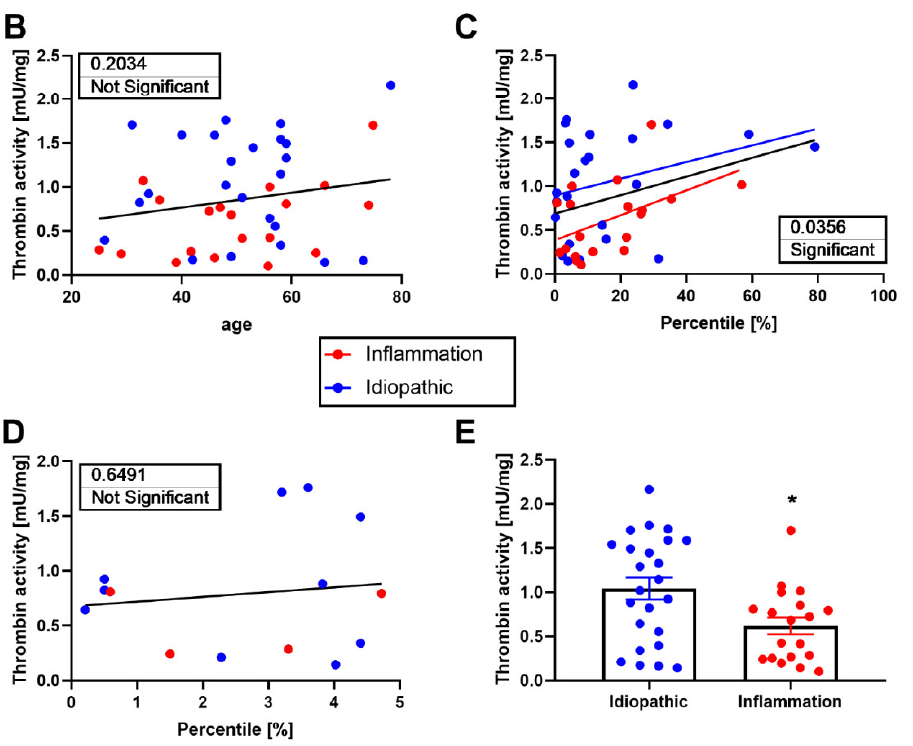
Figure 6. Thrombin activity in human skin: ( A ) Representative pictures of small-fiber staining of control (upper panel) and SFN (lower panel) patients. ( B ) No correlation was found between thrombin activity and age in all patients. p = 0.2, R 2 = 0.04, n = 43. ( C ) A significant correlation was found between thrombin activity and percentile in all patients. p = 0.035, R 2 = 0.1 for all patients; p = 0.032, R 2 = 0.24 for inflammation; and p = 0.15, R 2 = 0.09 for idiopathic. n = 43. ( D ) No correlation was found between thrombin activity and percentile in SFN patients. p = 0.6, R 2 = 0.02, n = 14. ( E ) Significantly increased thrombin activity was found in idiopathic patients (blue) compared with in inflammatory patients (red). n = 23 and 20, respectively. Results are presented as mean ± SEM, * p = 0.0035.